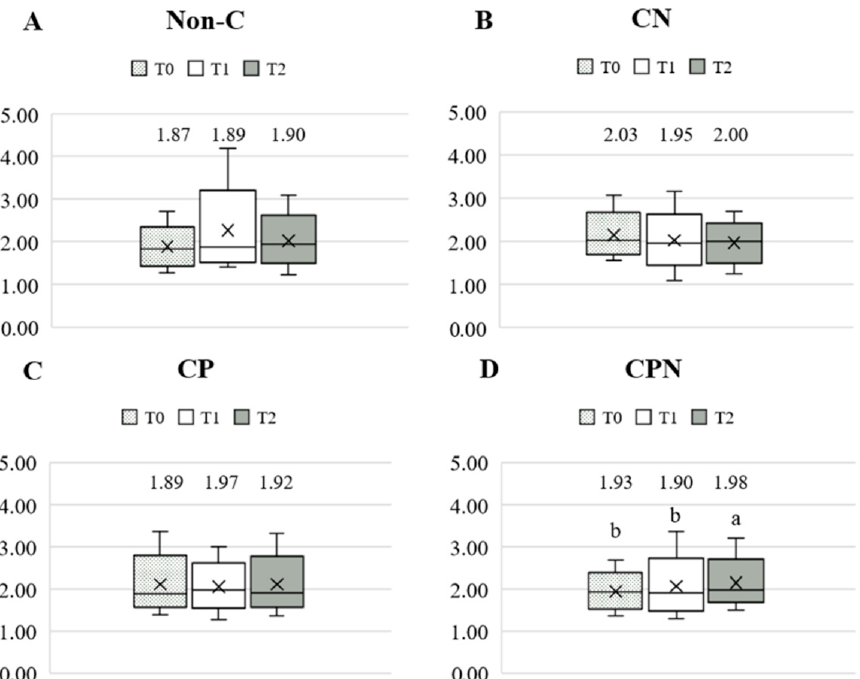
Figure 4. Comparison of the h/H during the experiment. ( A ) Non-C group; ( B ) CN group; ( C ) CP group; and ( D ) CPN group. h/H: hypocholesterolemic/hypercholesterolemic ratio; T0: baseline; T1: intervention; T2: follow-up; non-C: no course for patients and nurses; CN: course for nurses; CP: course for patients; and CPN: course for patients and nurses. Values were presented as medians. Statistical analyses were conducted using the Wilcoxon signed-rank test. The different superscripts, “a, b”, denote a significant difference within groups ( p < 0.05). Table 3. Comparison of the changes in the h/H in the different education models during the exper- iment, with non-C as the reference group.